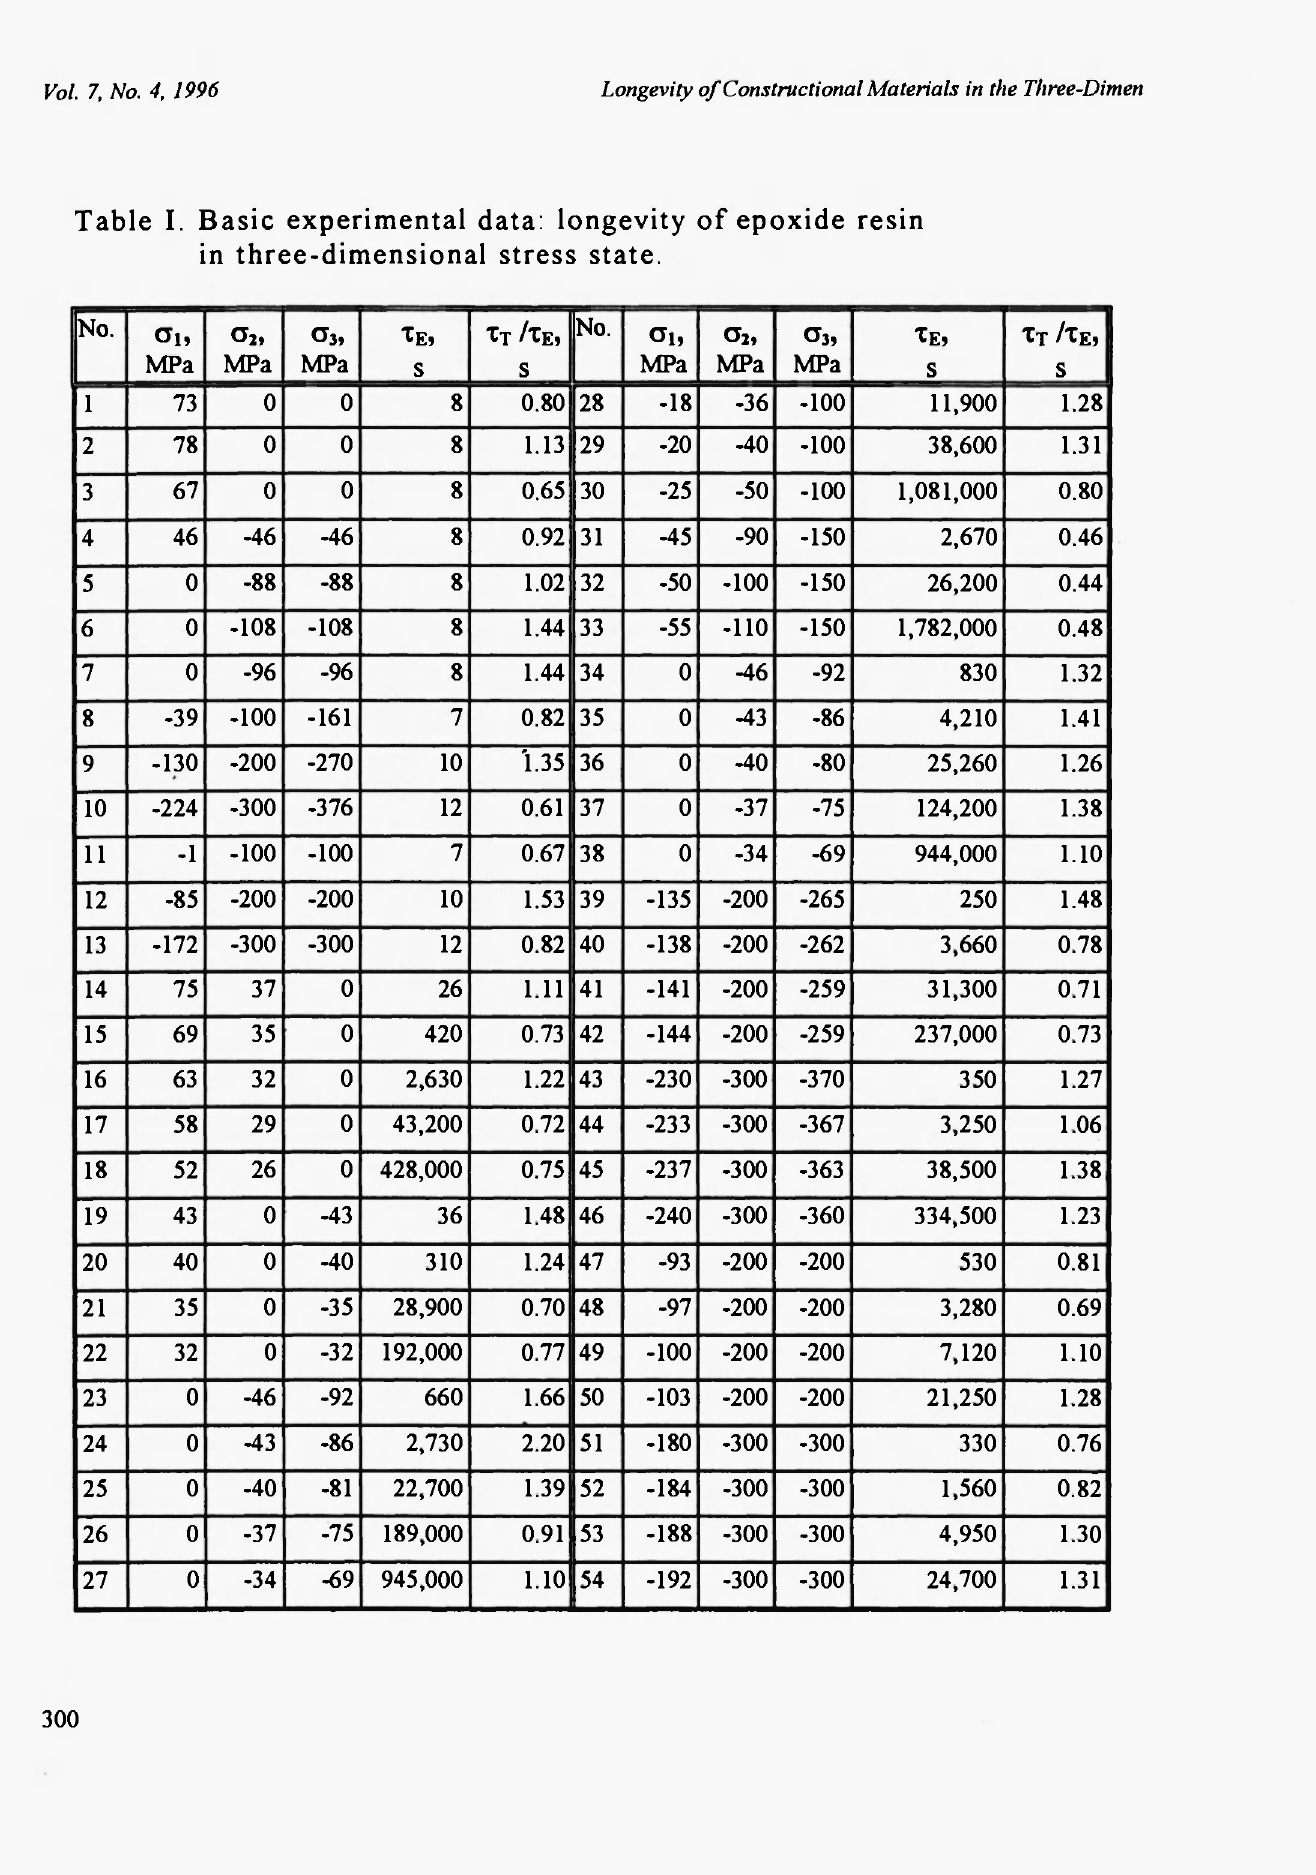
Table I. Basic experimental data: longevity of epoxide resin in three-dimensional stress